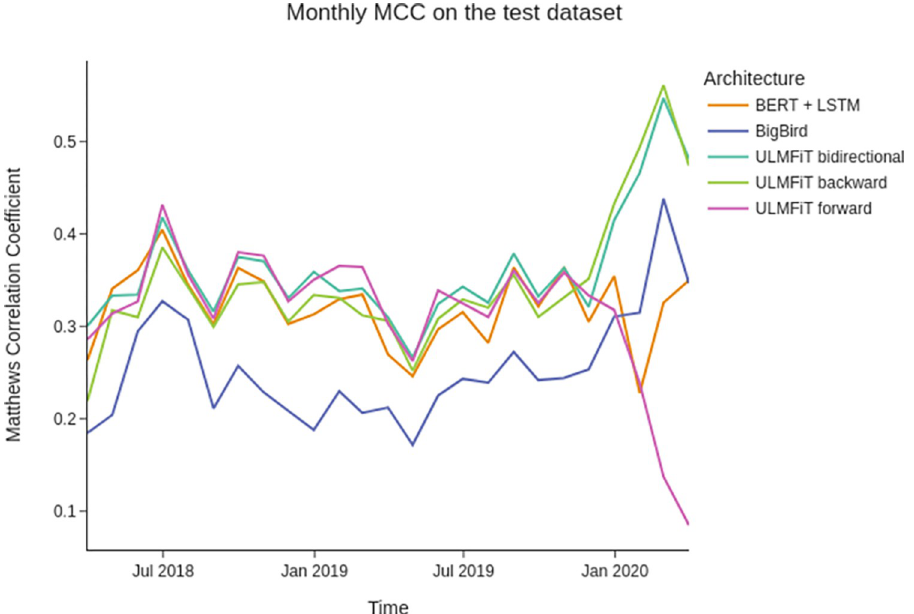
Fig 4. Matthews Correlation Coefficient for each architecture on the test dataset. We calculated the MCC considering all appeals tried each month. The monthly MCC for all models remains constant during the timeframe of the test dataset, showing no evidence of data